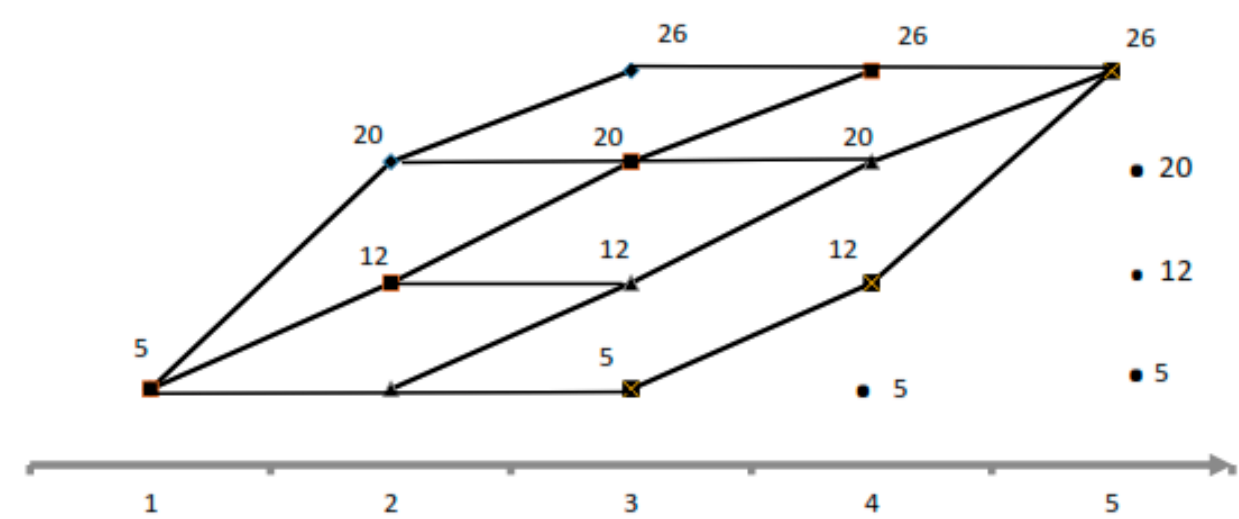
Figure 1. Conventional wind farm construction options. Notes: Project implementation conditions (process axis): 1—transportation; 2—power supply; 3—preparation; 4—maintenance; 5—financial assurance capacities.